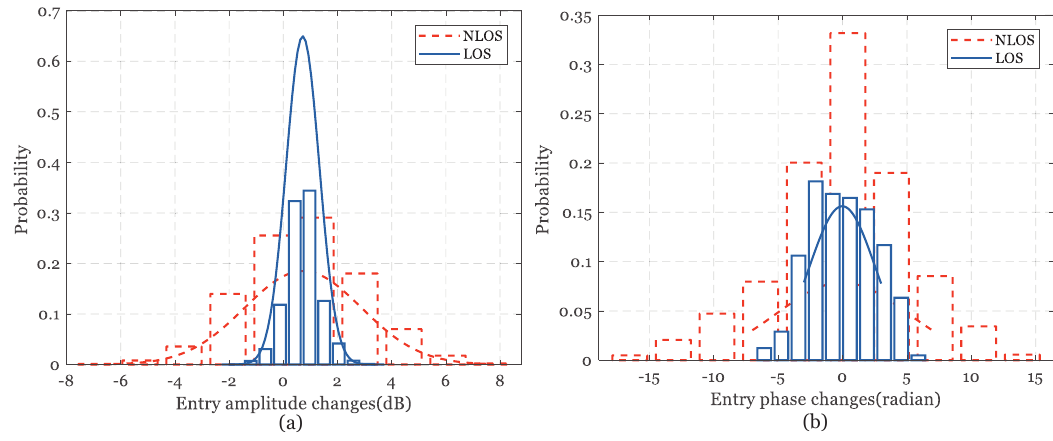
Figure 9. Temporal variances of CSI in LOS and NLOS. ( a ) CSI amplitude variances between adjacent entries. ( b ) CSI phase variances between adjacent